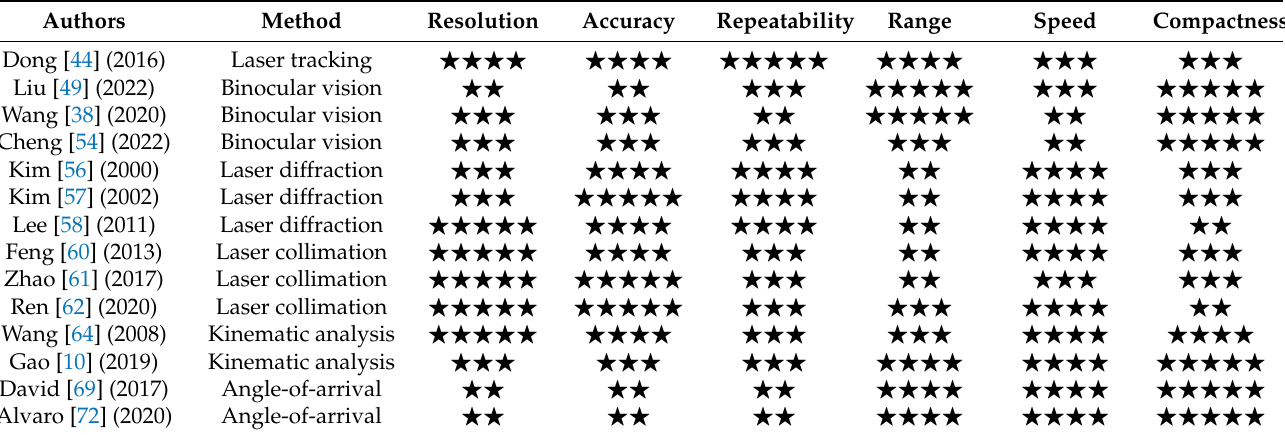
Table 3. Summary of 6-DOF posture measurement methods using